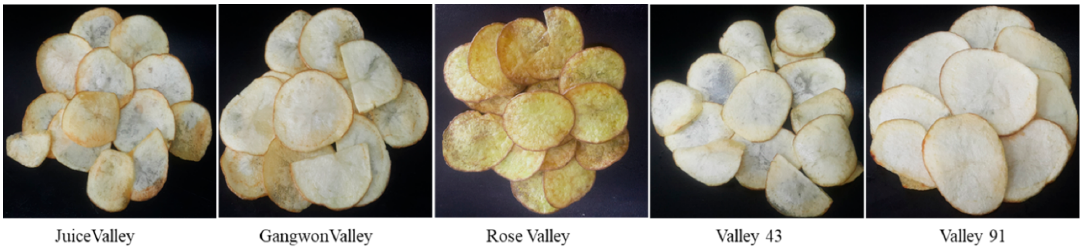
Figure 4. Correlation between chip lightness and glucose content of 35 potato lines harvested in Yang-gu, South Korea.